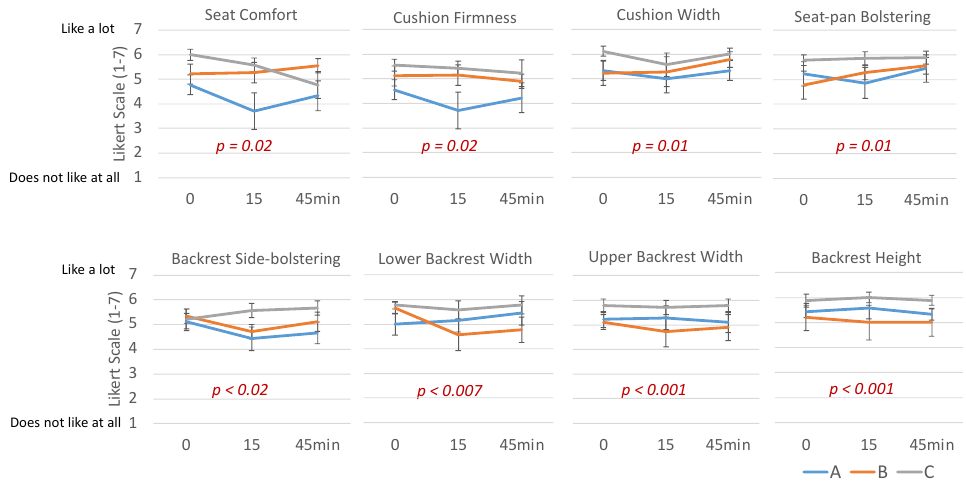
Figure 9. Dynamic seat comfort comparisons among the three seats (A-blue lines, B-orange lines, C-gray lines) during the 50 min of vibration exposures (15-min field vibration and 30-min sinusoidal vibration) ( n = 10).